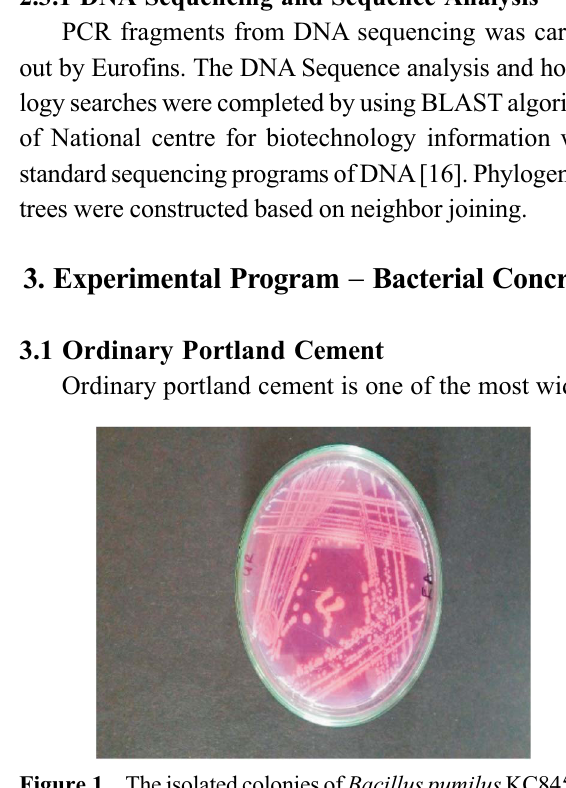
Figure 1. The isolated colonies of Bacillus pumilus KC845305 developed on Christensen